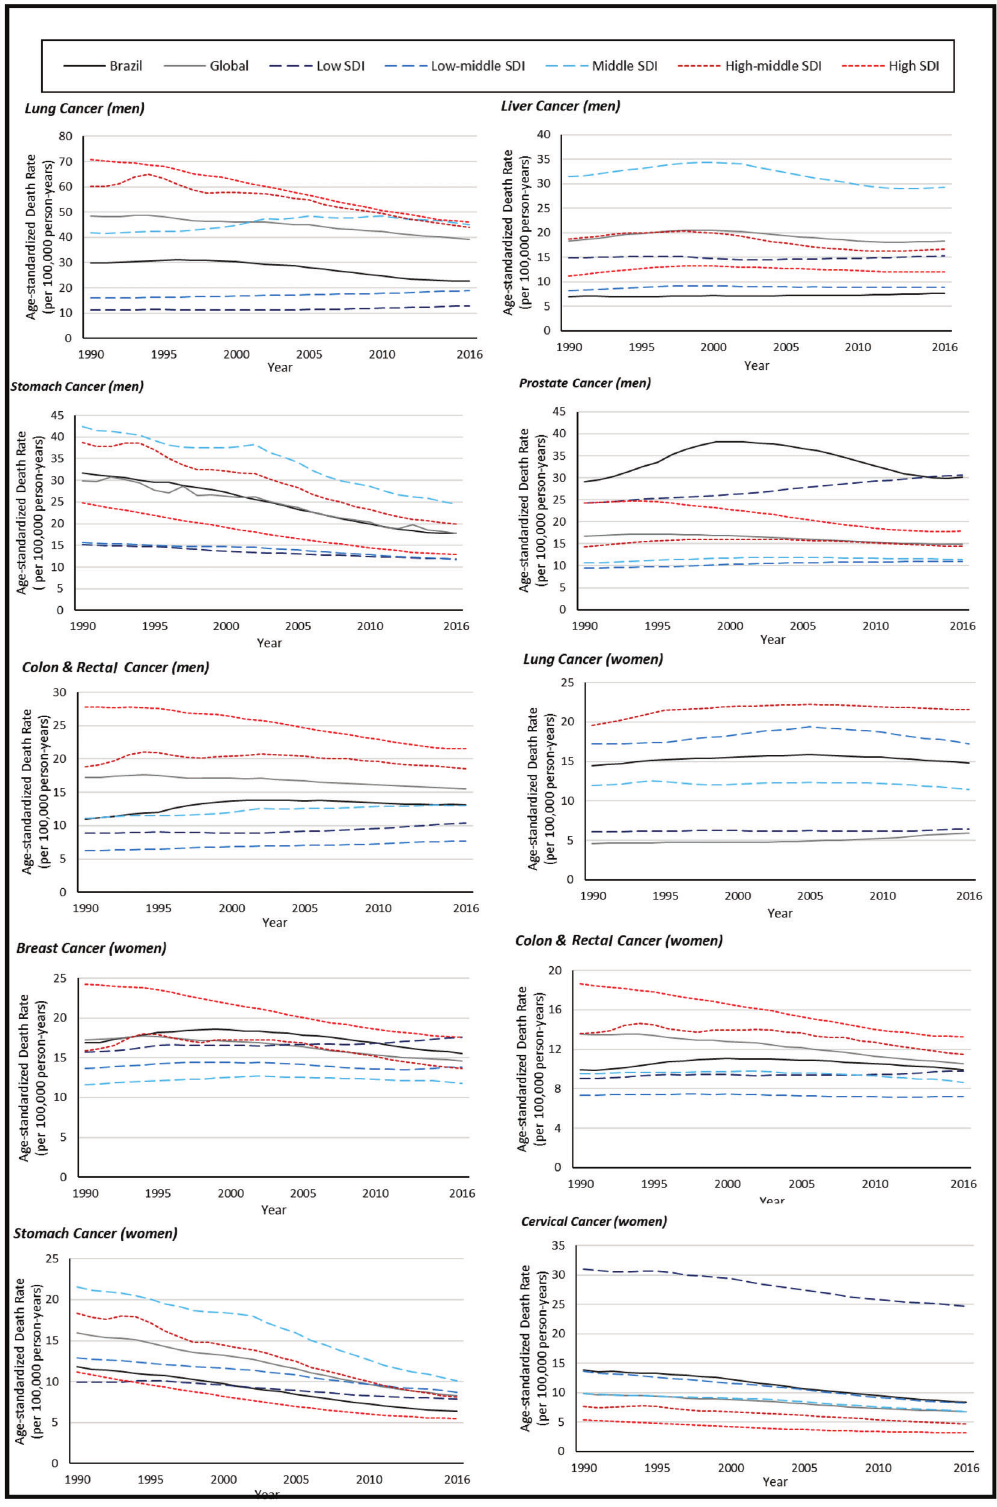
Figure 1 - Age-standardized cancer-specific mortality rates in men and women. Source: Global Burden of